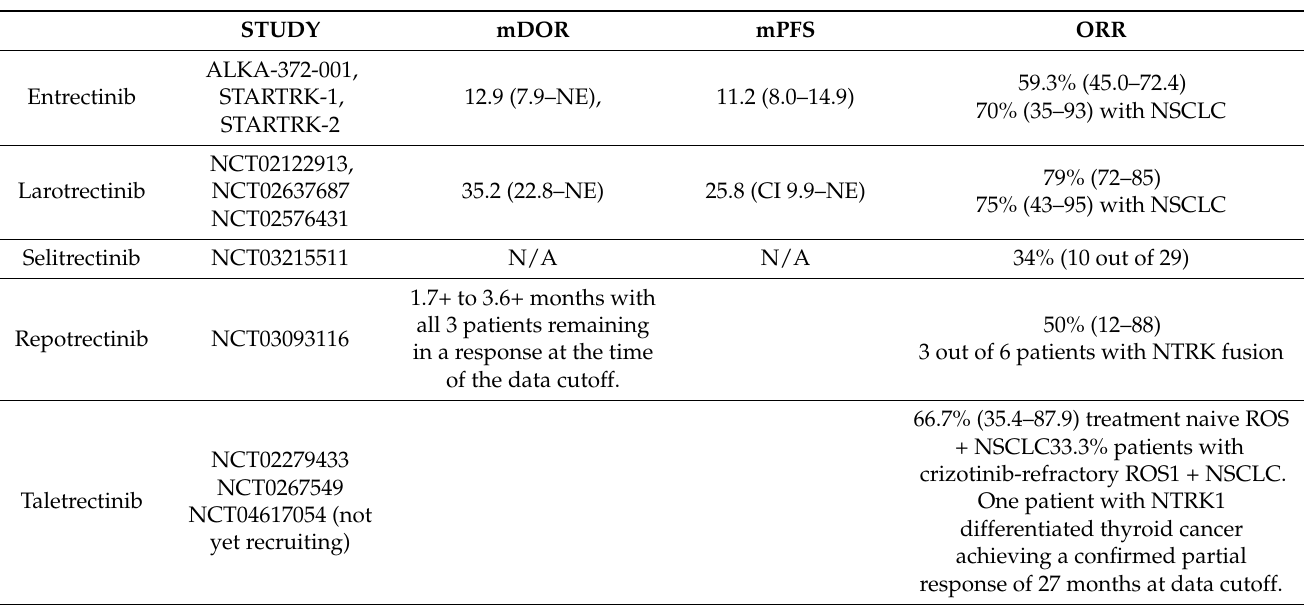
Table 2. Detailed results of NTRK TKI